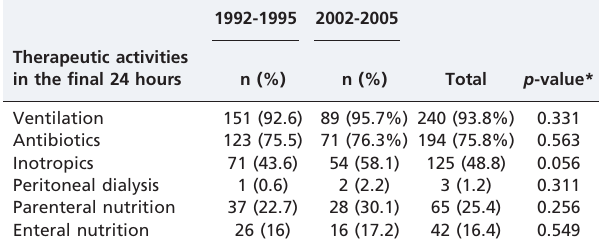
Table 2 - Therapeutic activities in the final 24 hours in the two